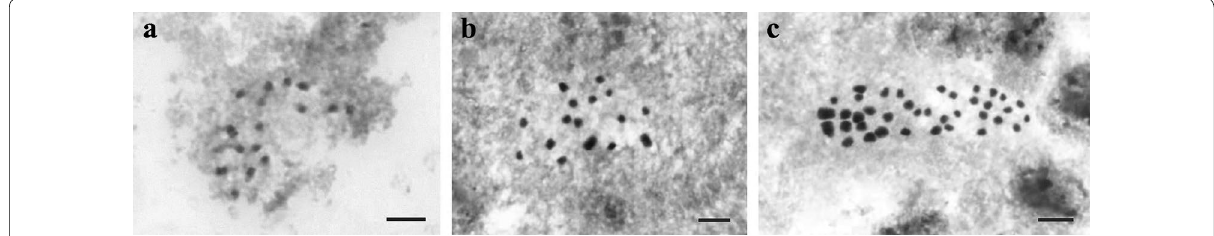
Fig. 4 Somatic chromosomes at metaphase of Begonia . a B. griffithiana (2 n (2 n 38, Peng 23566 ). Scale bar 5 =